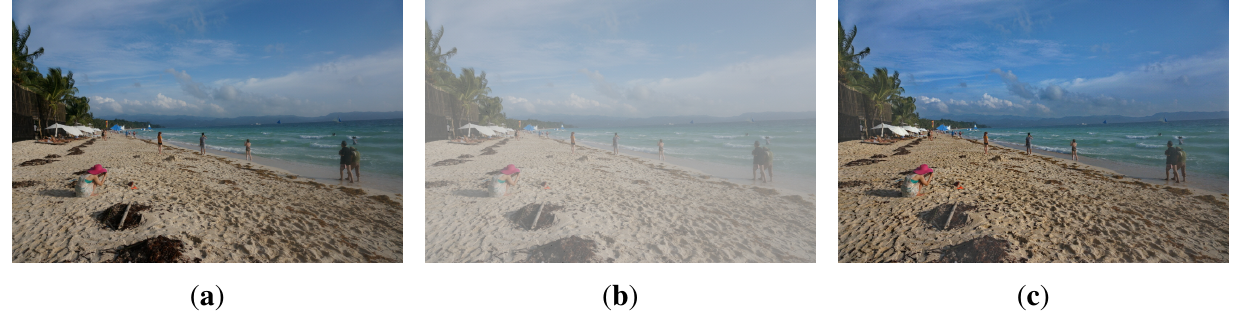
Performance evaluation of color restoration using a simulated hazy image: ( a ) original haze-free image; ( b ) the simulated hazy image; and ( c ) the dehazed image using the proposed method.